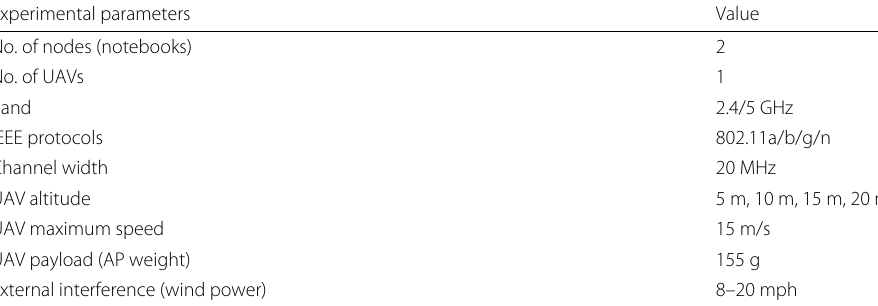
Table 3 Experimental parameters for our testbed Experimental